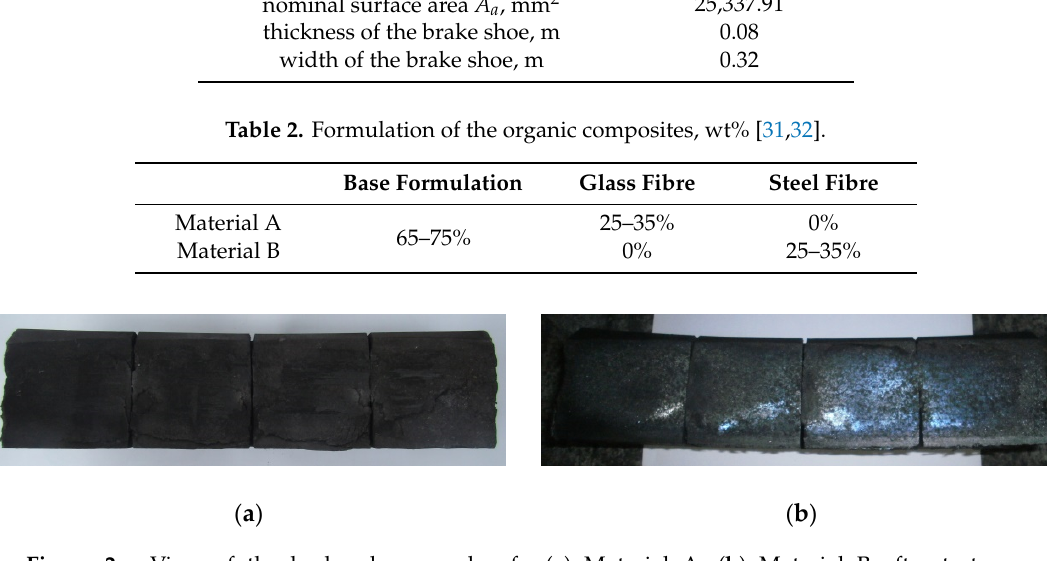
Figure 2. View of the brake shoes made of: ( a ) Material A; ( b ) Material B after tests on a full-scale